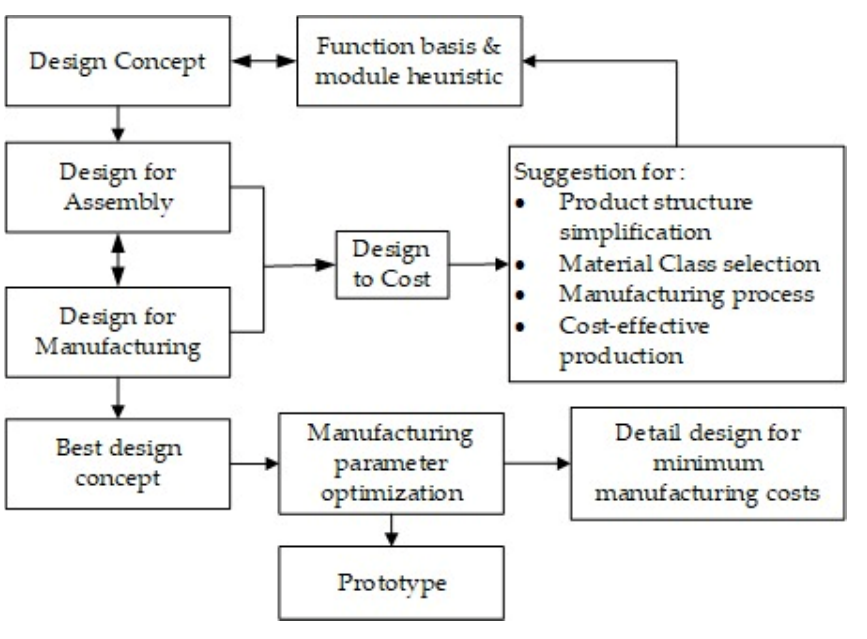
Figure 1. DFMA vs Design to Cost frameworks [39].